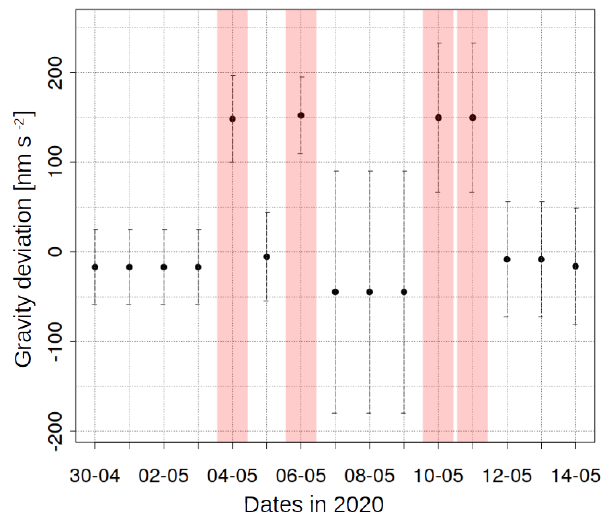
Figure 9. Residual gravity values in nms − 2 obtained with the AQG-B01 during the Coriolis tests at Géosciences Montpellier in 2020: the red bars show a sensor head orientation of 180 ◦ com- pared to the default set-up. Error bars refer to the standard deviation during 24h. The value of g averaged over 24h obtained on 10 June 2020 with the FG5-228 was subtracted. Horizontal grid lines show steps of 50nms − 2